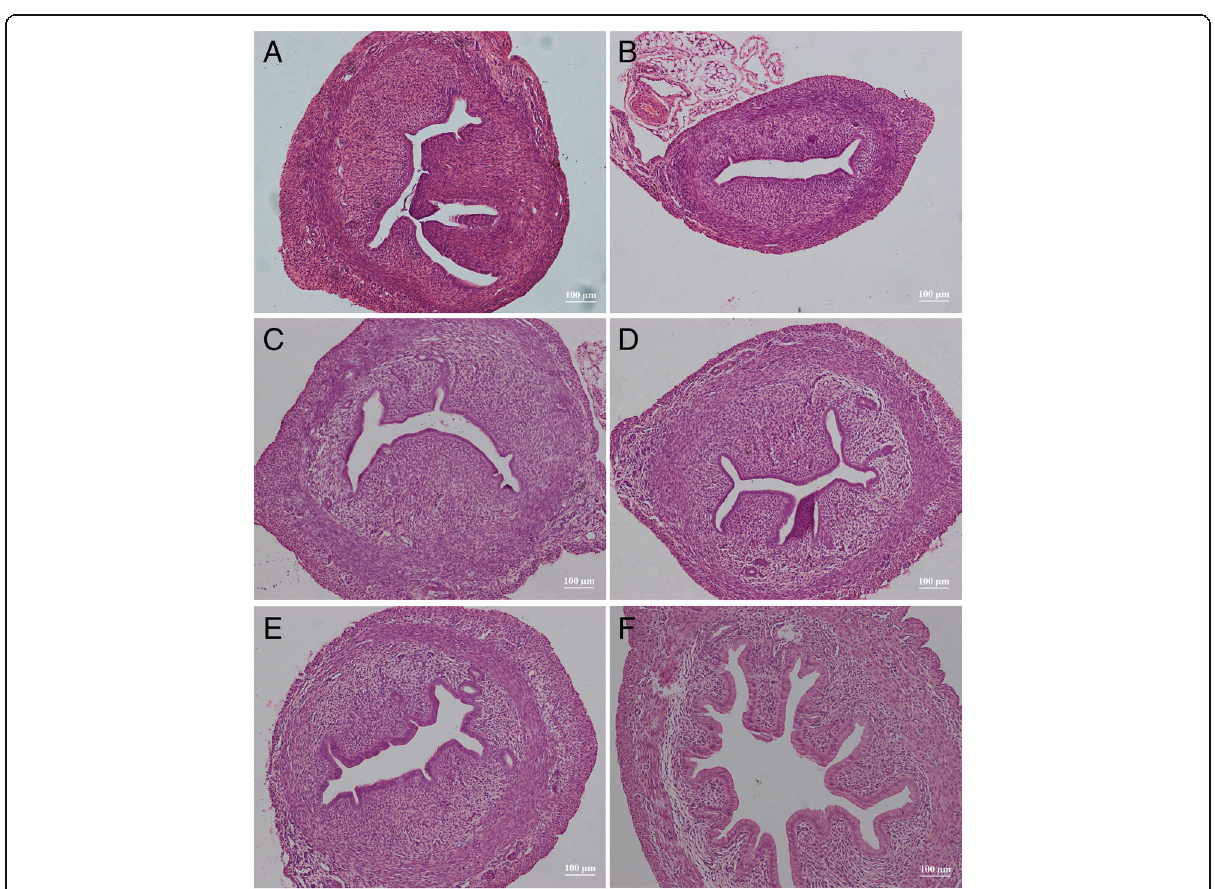
Fig. 6 Hematoxylin and eosin stained images of the uterus from solvent control ( a ) and rats receiving DES dosages of 0.25 ( b ), 0.5 ( c ), 1.0 (D), 2.0 ( e ), and 4.0 μ g/kg body weight ( f